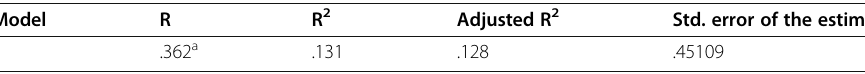
Table 9 Model summary Model